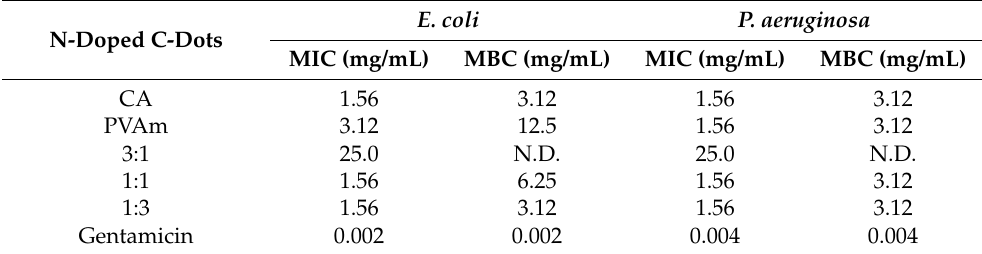
Table 4. Minimum inhibition concentration (MIC) and minimum bactericidal concentration (MBC) of CA, PVAm, and N-doped C-dots prepared at 3:1, 1:1, and 1:3 ratios against E. coli and P. aeruginosa Gram-negative bacteria according to microtiter dilution assay. Gentamicin was used as a control. N-Doped